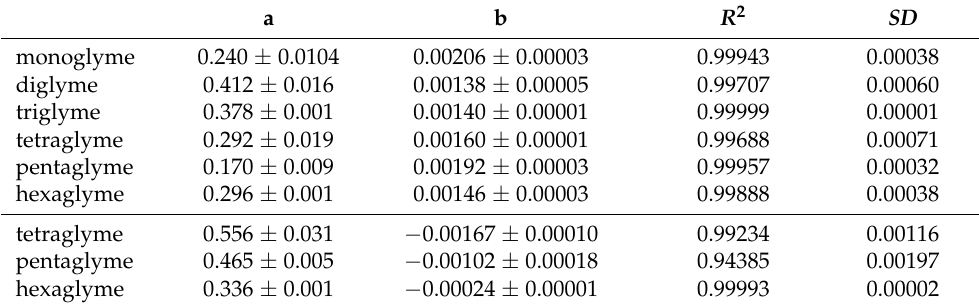
the mole fraction of water ( x W ) corresponding to the first and second intersection points in relation to temperature.